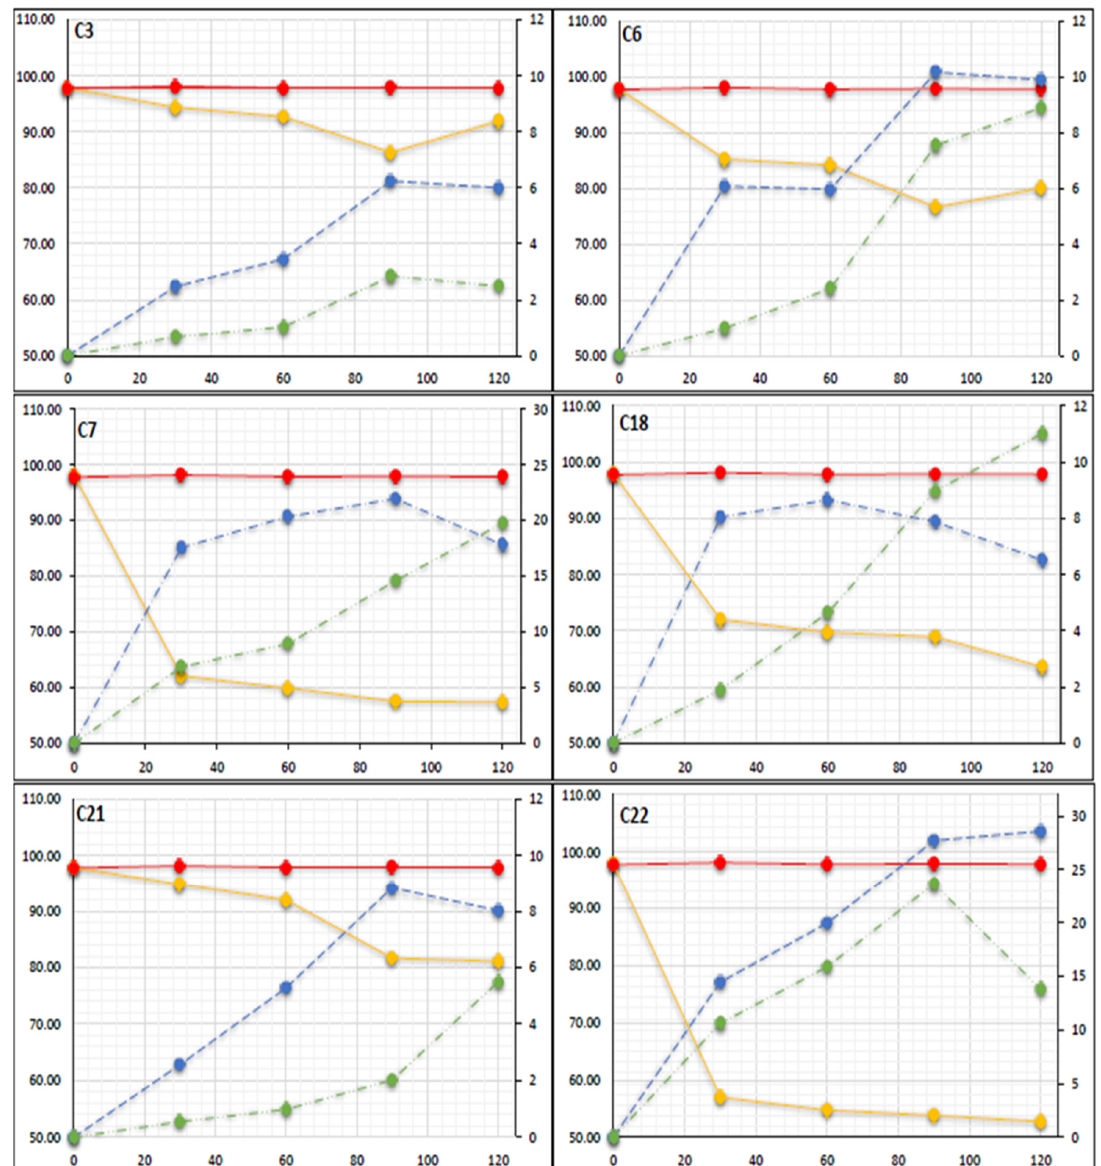
Figure 3. GC-MS quantification analysis of TBT (100 ng/g) spiked sedimentary microcosms inoculated with microbes; C3, C6, C7, C18, C21 and C22 over a 120-day period (Data presented as mean by repeated measures ( n = 3)). Dual y-axis ng/g, left y-axis represents TBT (gold) degrading and right y-axis represents the formation of DBT (blue) and MBT (green) red plot represents TBT in control microcosms x-axis represents sampling days.